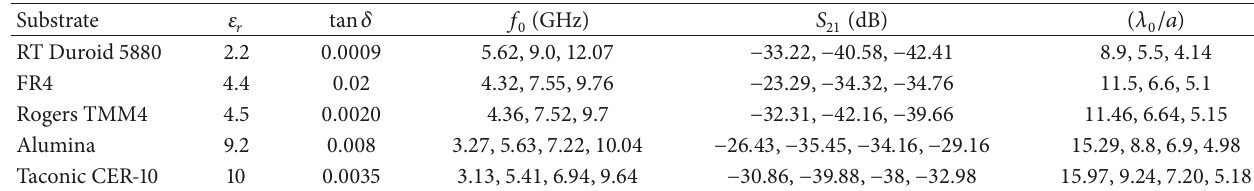
Table 2: Effect of substrate properties on simulated resonant frequency 𝑓 0 (GHz), transmission minima 𝑆 21 (dB), and effective medium ratio (𝜆 /𝑎) . 0